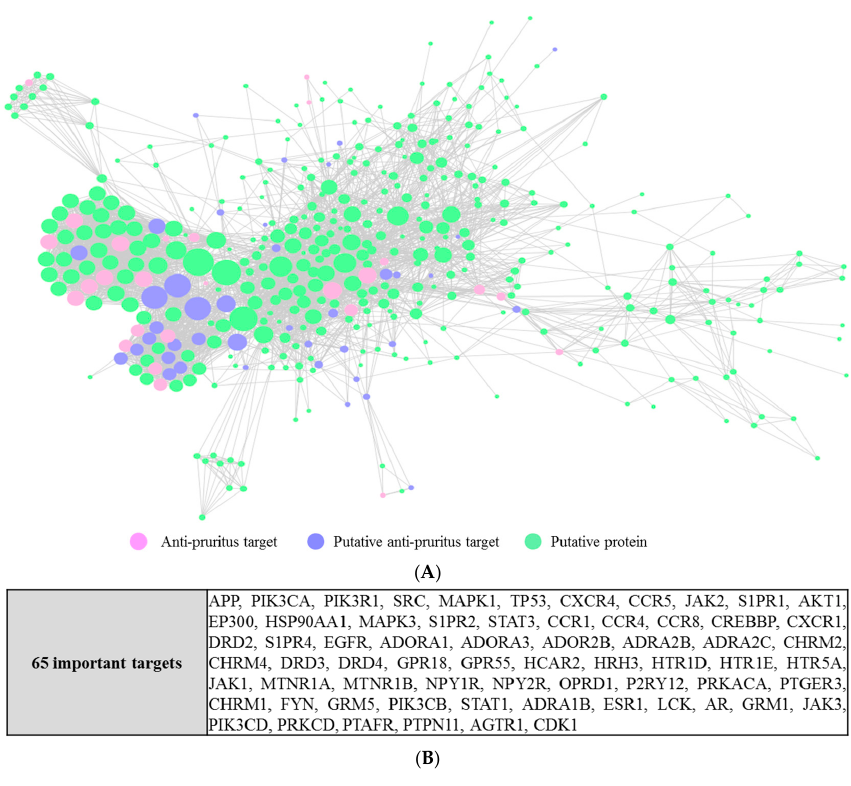
Figure 4. Protein–protein interaction (PPI) network of anti-pruritus targets and proteins that directly or indirectly interact with the targets. ( A ) The PPI network of anti-pruritus protein targets (The size of the circle represents the degree of a node); ( B ) A list of 65 important proteins which interact with the anti-pruritus targets.